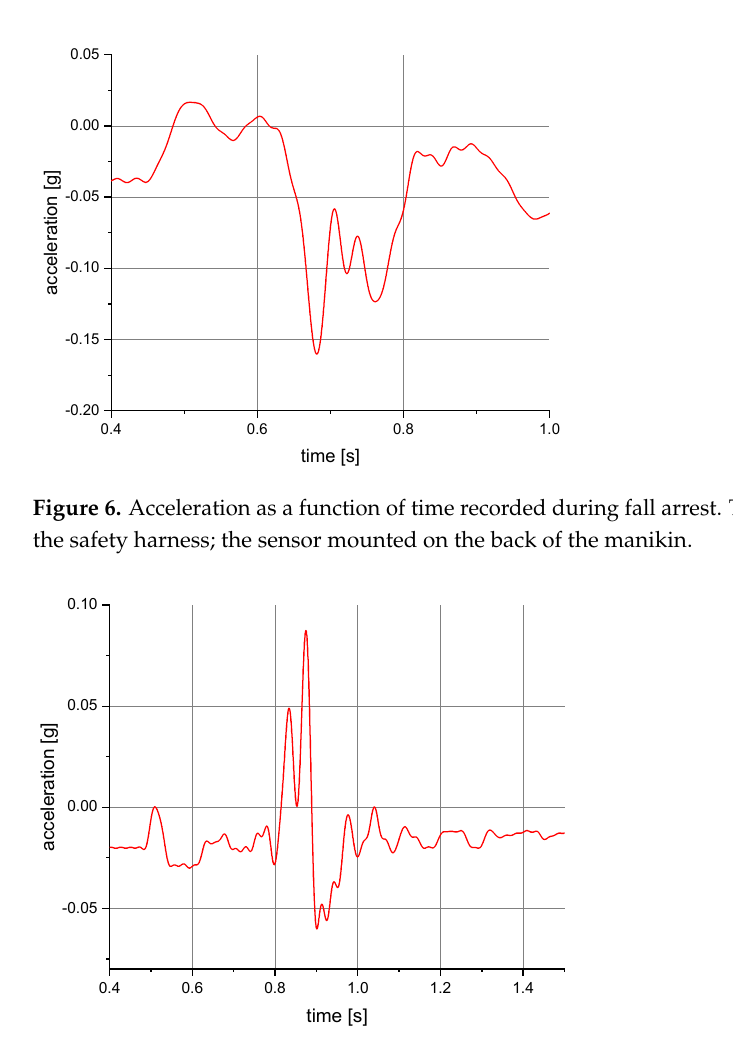
7 of 12 Figure 4. Acceleration as a function of time recorded during fall arrest. Test conditions: front point of the safety harness; the sensor mounted on the back of the manikin. 0.4